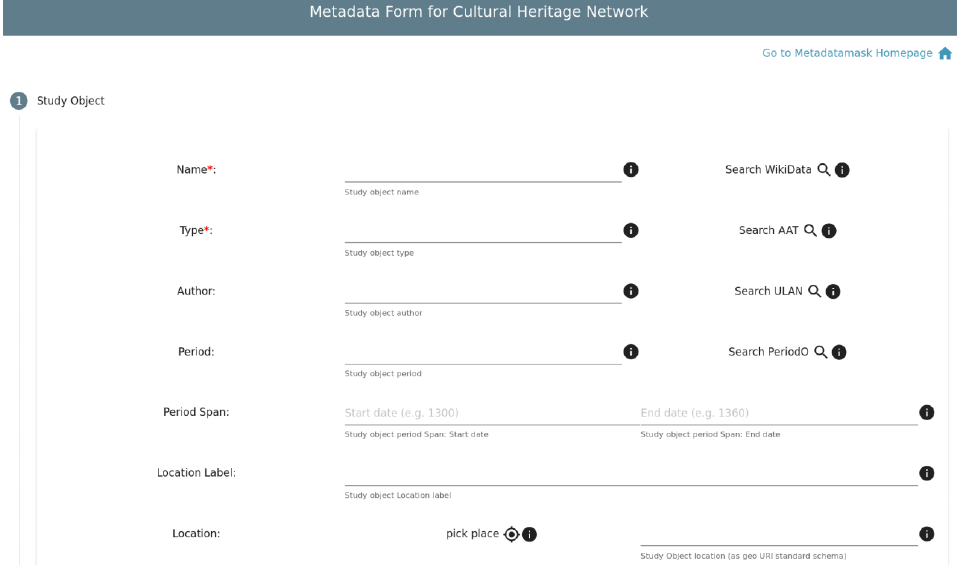
Figure 1. View of the THESPIAN-Mask page devoted to the insertion of a new metadata record. The buttons for accessing third-party APIs are shown.